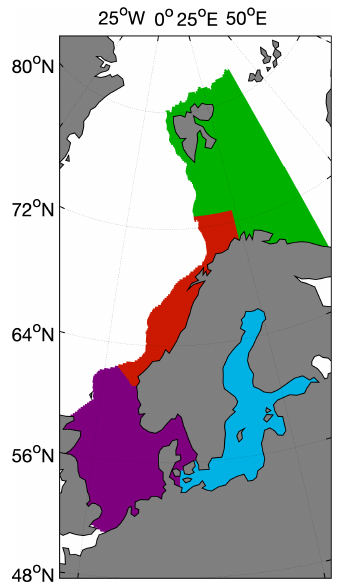
Figure 1. The study area and the location of the four different regions: North Sea (purple), Norwegian Coast (red), Barents Sea (green) and Baltic Sea